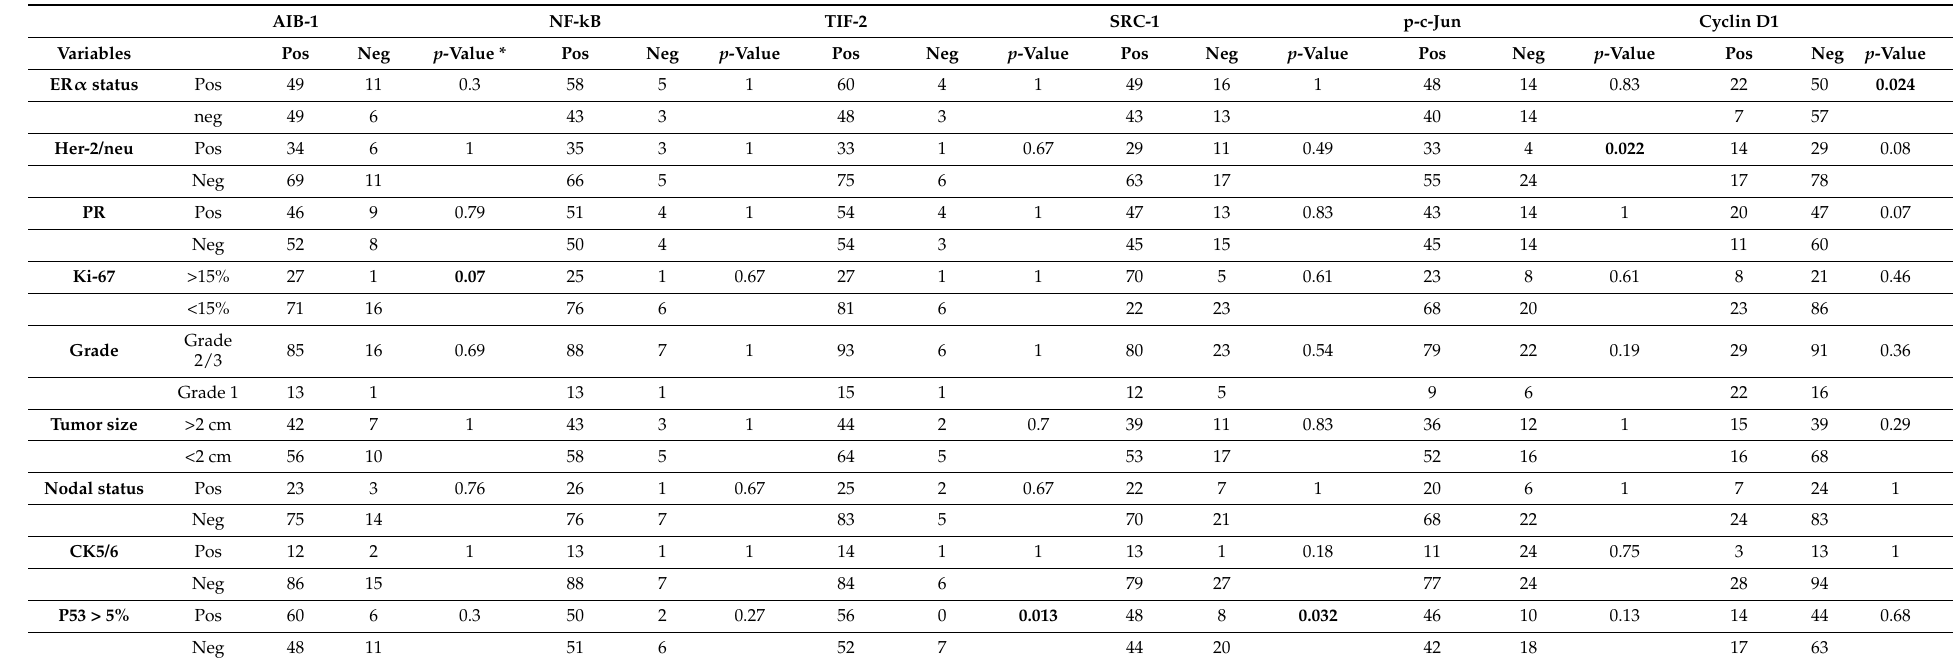
Table 2. Association between coactivators and clinical